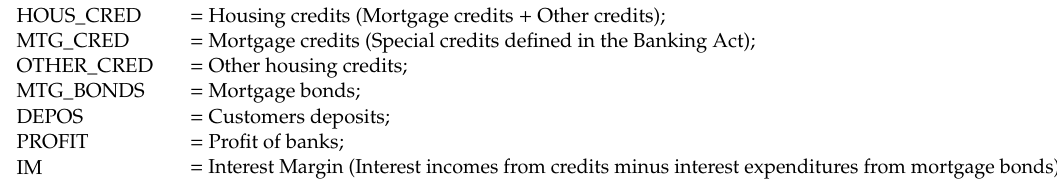
Table 2. Variables used for the panel regression models and for DEA models